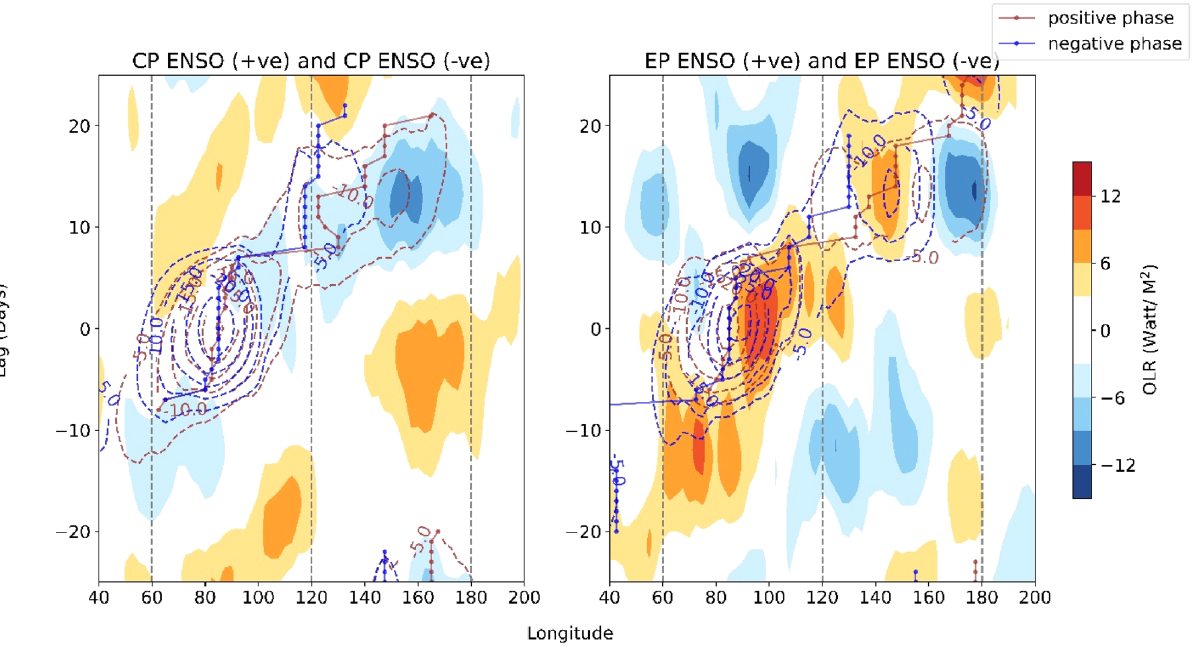
Figure 6. Lag propagation of 20–100 days filtered OLR (Watt/m 2 ) with respect to central Indian Ocean (80°E–90°E, 15°S–15°N). Left panel shows the MJO propagation during positive (brown contour) and negative (blue contour) CP-type ENSO phases. The shade denotes the difference in MJO propagation between warm and cold phases. The dotted lines represent the location (longitude) of maximum lag-correlation with central Indian ocean at each time lag (brown: warm phase, blue: cold phase). This indicate the path of the MJO center as a function of time lags. Similarly, as the left panel, the right panel shows the MJO propagation for the positive and negative EP-type ENSO